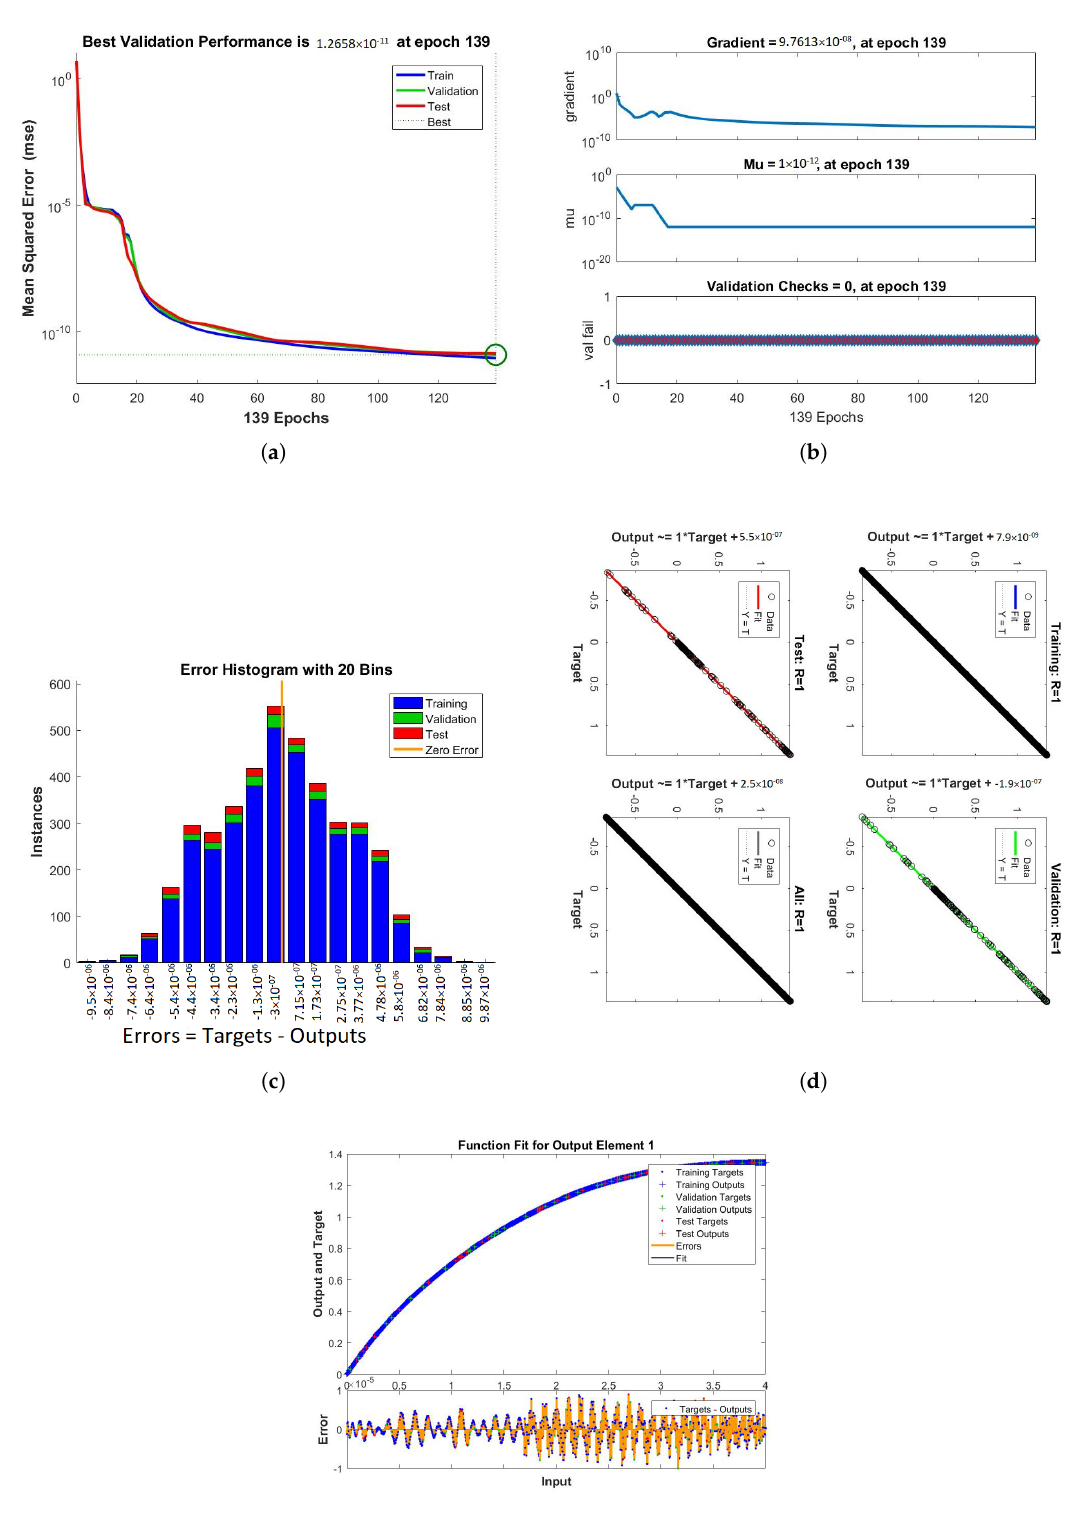
Figure 9. Performance, training, error histogram, regression, and fitness graphs of our system were obtained through LMBNN using the value of rotation parameter K = 0.1. ( a ) Performance. ( b ) Training. ( c ) Error Histogram. ( d ) Regression. ( e )